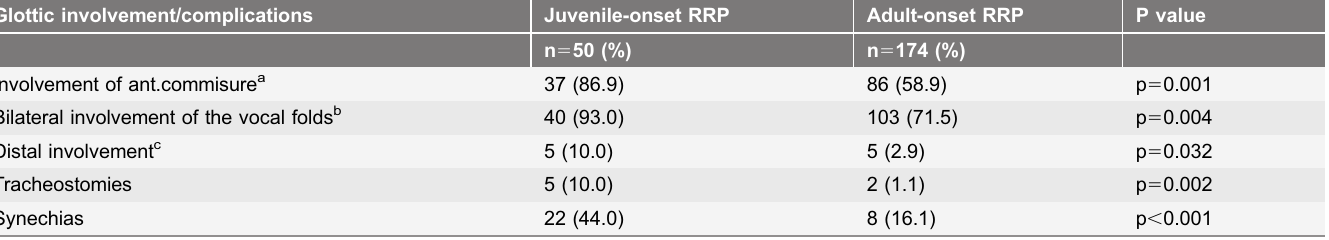
Table 3. Distribution of glottic involvement and complications of the disease stratified for juvenile and adults during observation time, n (% within adult/ juvenile group), n 5 224.